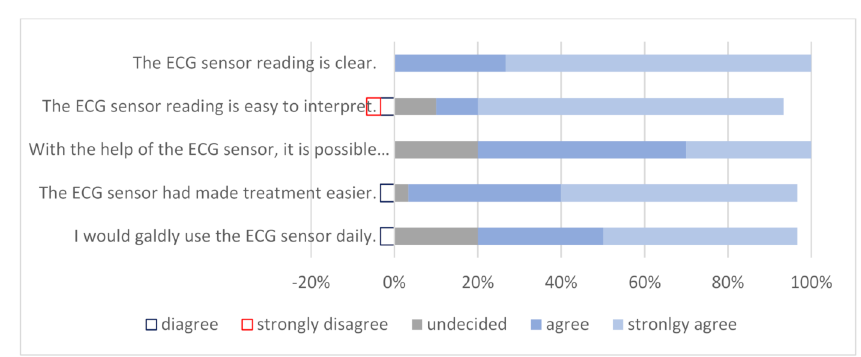
Figure 2. Physician satisfaction with ECG sensor